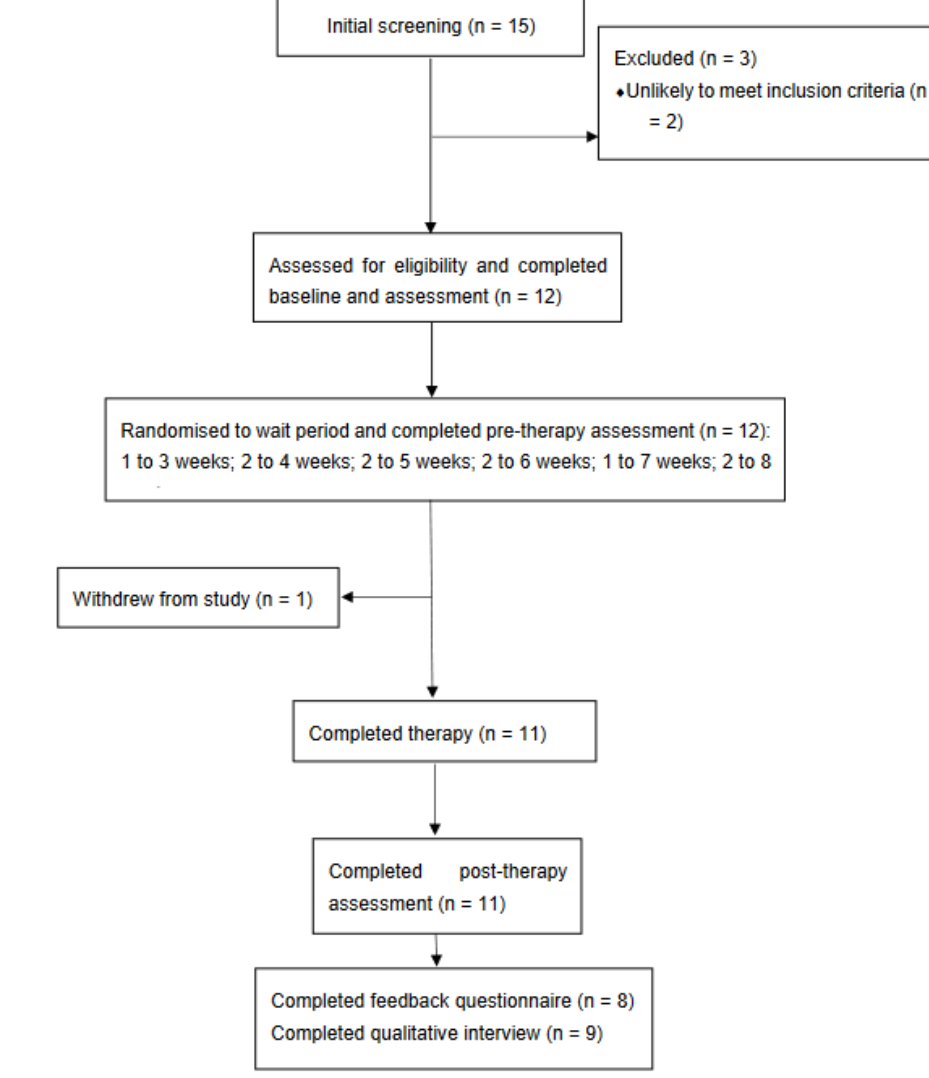
Figure 1. CONSORT diagram showing participant flow. Of the 12 participants randomised, one withdrew from the study after receiving seven sessions of therapy; the reason given was the impact of the onset of the COVID-19 pandemic upon their situation. Eleven participants thus completed the post-treatment as- sessment and the three-week post-treatment monitoring period. Of these 11, two did not have a stable pre-treatment baseline and so were not included in the analyses of reliable change. Table 2 displays demographic and clinical characteristics of the participants at study intake. The majority of the sample were female and all were white British, with a median age of 44 (range 31 to 65). Five were receiving care from secondary mental health services on an outpatient basis; the remainder were receiving their mental health care from their primary care physician. The mean duration of participants’ current depressive episode was 7.58 weeks, S D = 8.89, and participants reported having a median of 35 previous episodes, range = 5 to 120.